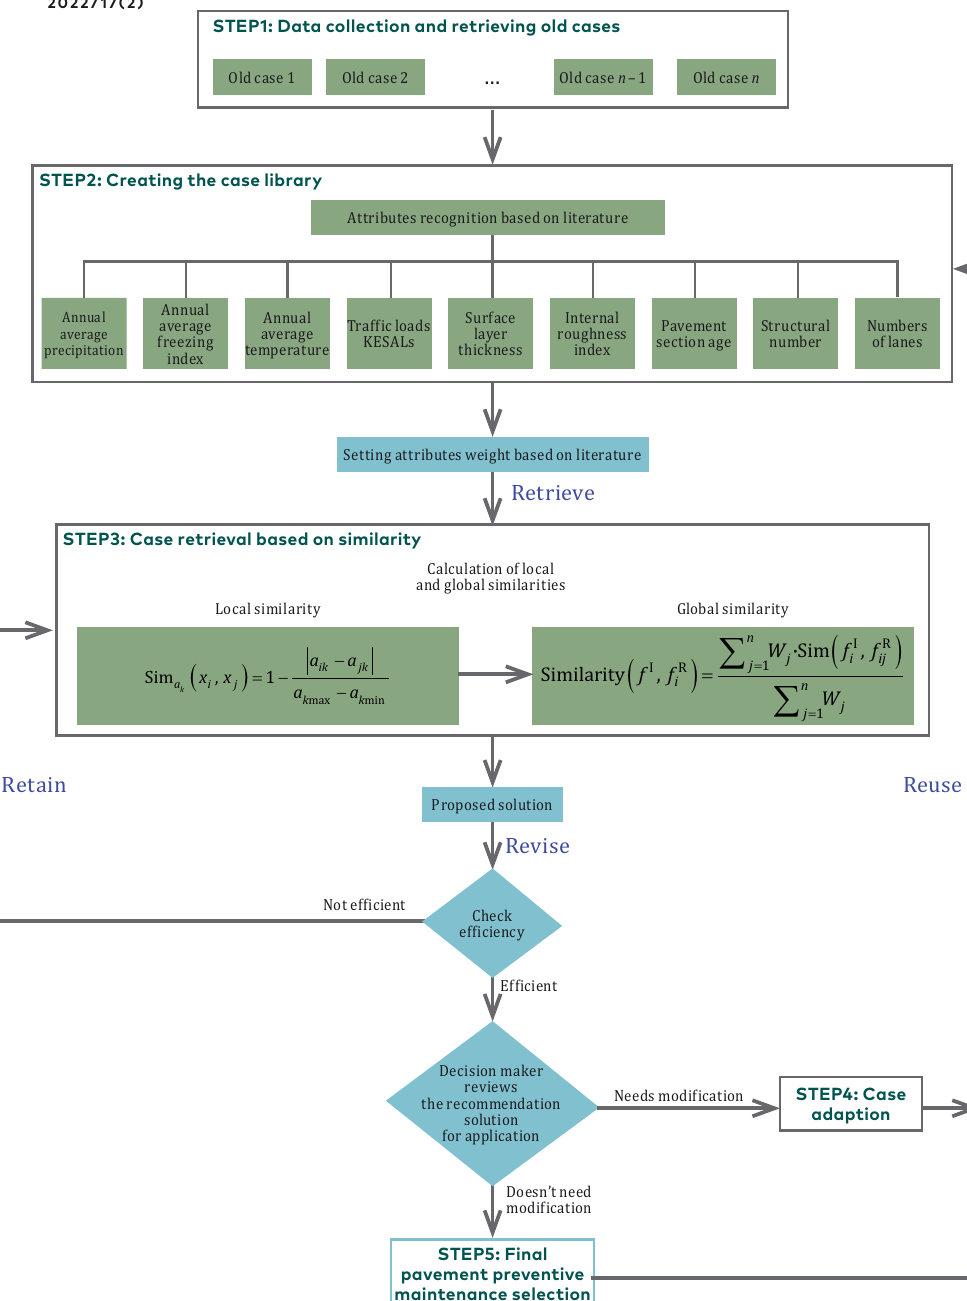
Figure 2. The proposed CBR-RF